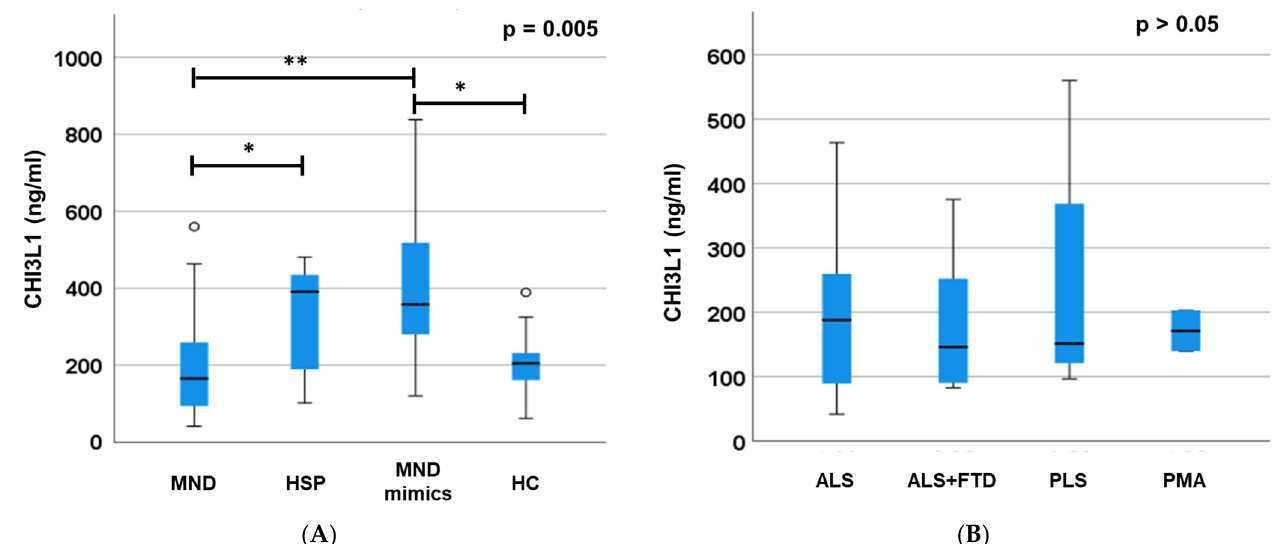
Figure 1. CHI3L1 plasmatic levels in MND, MND mimic, HSP, and HC. In MND mimics, we highlighted an important increase in CHI3L1 plasmatic levels compared to MND and HC ( A ).